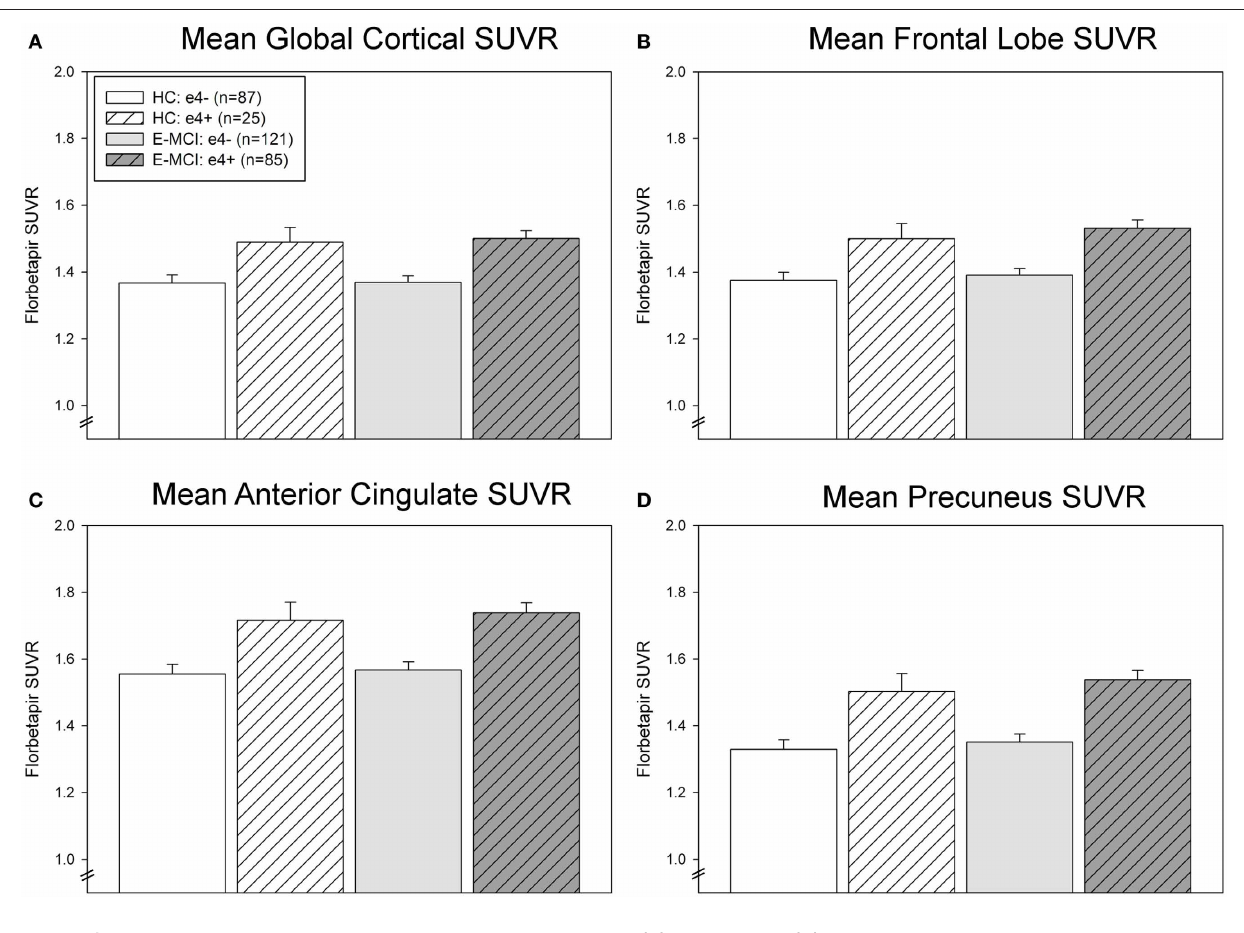
FIGURE 2 | Regional effects of APOE ε 4 status on amyloid deposition in E-MCI and HC participants. A significant effect of APOE ε 4 status on regional amyloid deposition was observed ( p < 0 . 001), including in the global cortical mean amyloid (A) , mean bilateral frontal lobes (B) , anterior cingulate